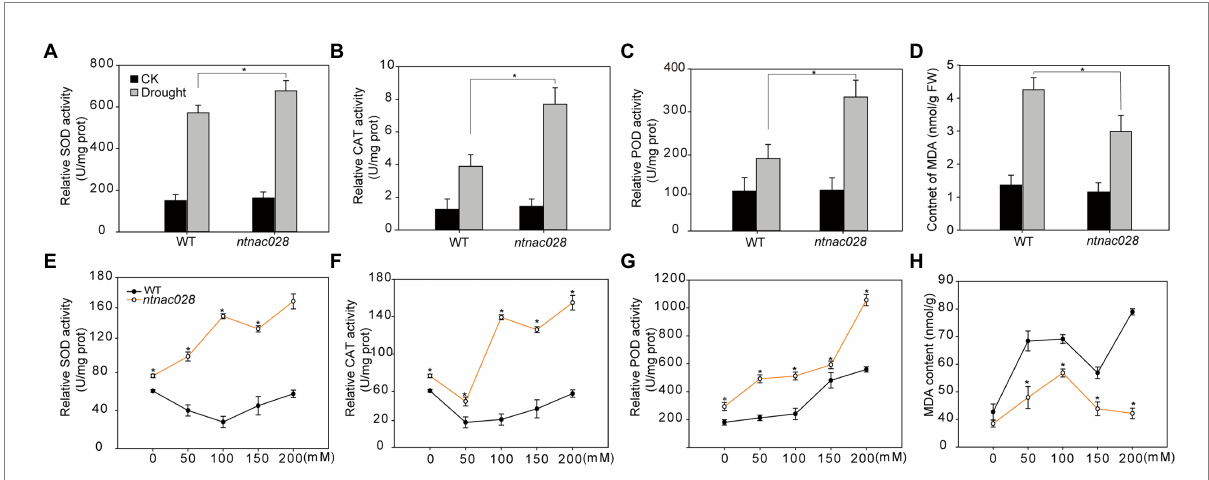
FIGURE 6 NtNAC028 mutation enhances the antioxidant activity of tobacco under abiotic stresses. (A–C) POD, SOD, and CAT activities of WT and ntnac028 plants with or without drought stress treatments. (E–G) POD, SOD, and CAT activities of WT and ntnac028 plants under various concentrations of NaCl. (D,H) MDA contents of WT and ntnac028 plants under drought and salt treatments. The bars are standard deviations (SD) of three biological replicates. Asterisks indicate statistically significant difference from WT (* p <